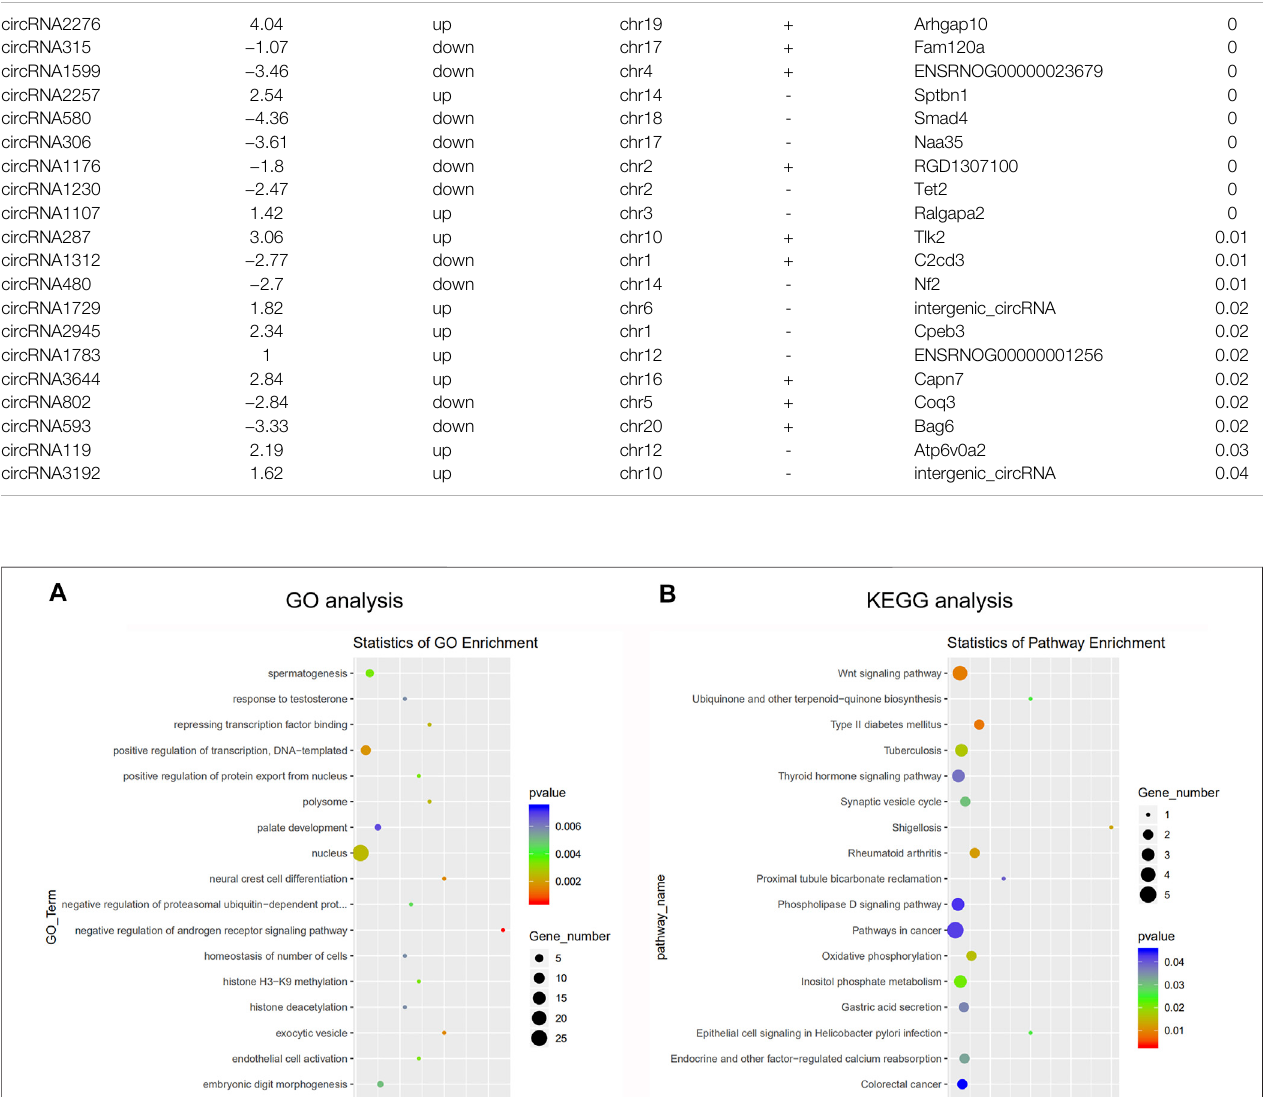
TABLE 2 | Top 20 of differential expressed circRNAs between young group and old group in rat subcutaneous adipose tissue. circRNA